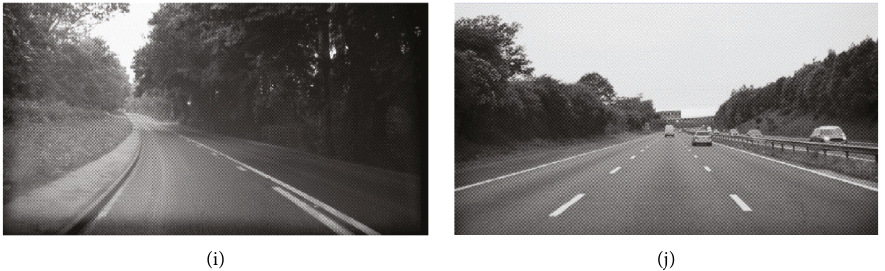
Figure 9: Characteristic snapshots from the video sequences inherent within the component sequences of the chain summarized in Table 21. The figures are numbered with the sequence numbers given therein.